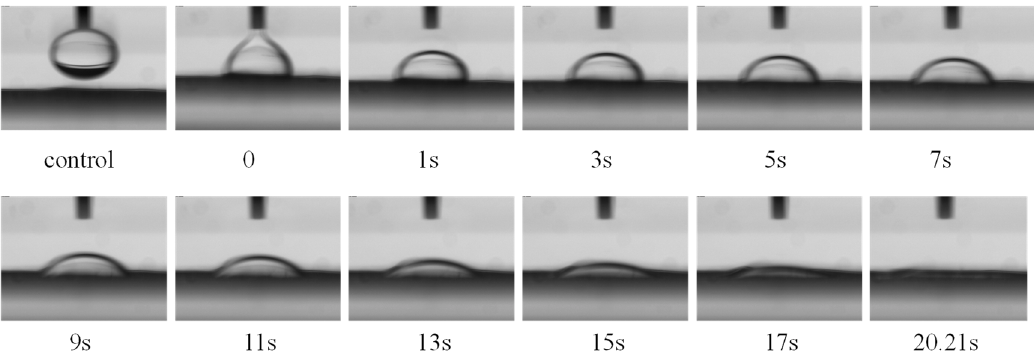
Figure 7. The diffusion of the water solution on the cellulosic fiber surface in the siloxane non-aqueous media.